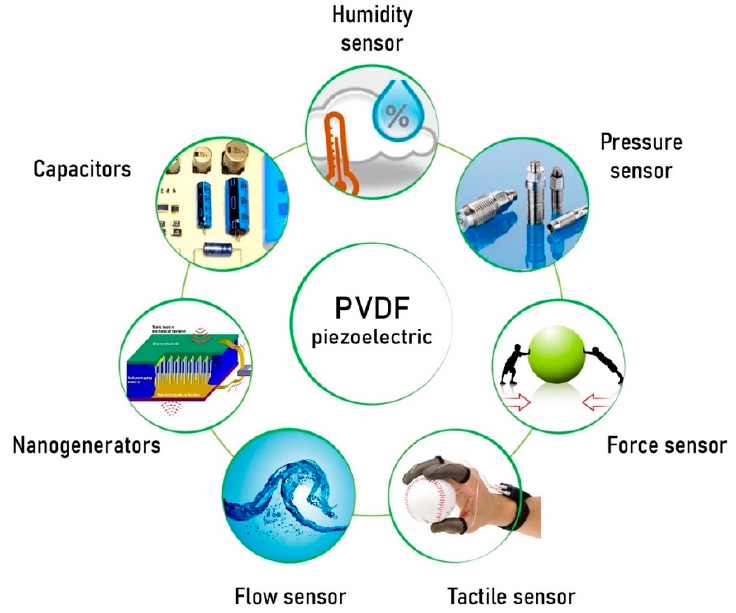
Figure 16. Applications of piezoelectric electrospun PVDF films for different devices.